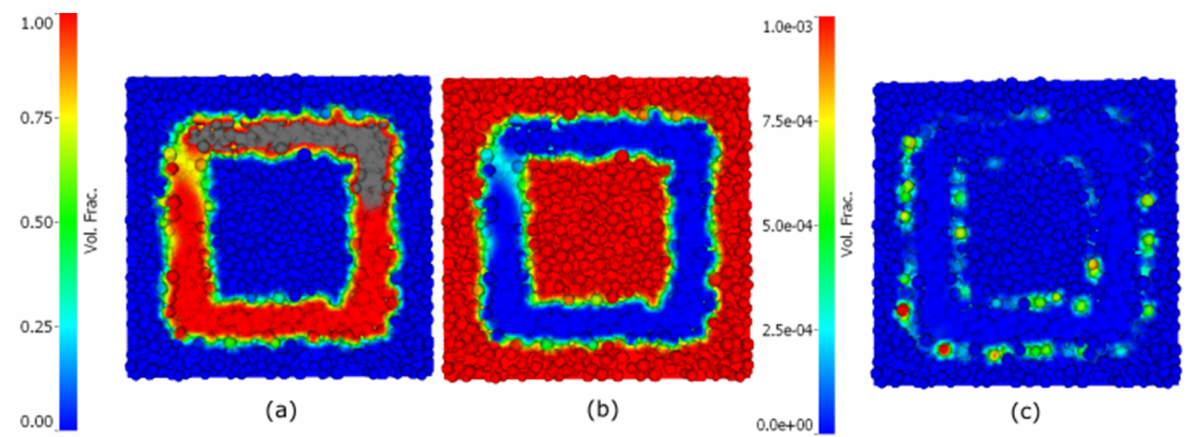
Figure 6. Volume fractions of microstructure phases of the powder bed at time t = 0.004 s ( a ) β ; ( b ) α ms ; ( c ) α wid . The grey section in the β plot denotes the melted Ti-6Al-4V state.